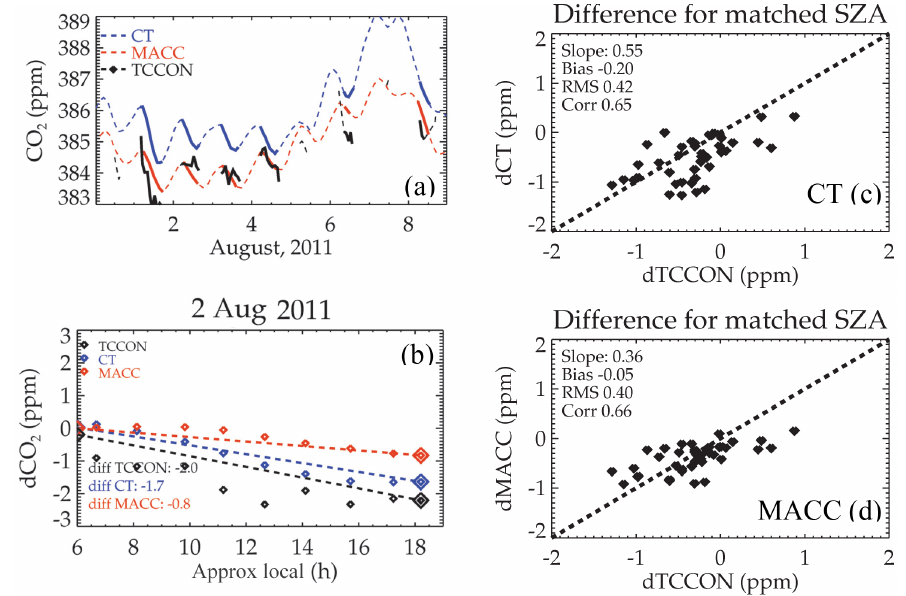
Figure 12. (a) Time series for models and TCCON from 1 to 8 August 2011 at Bialystok. The end points of the solid lines show the time points used for comparing daily variability; both diurnal and synoptic variations are seen. (b) Change throughout the day at Bialystok for 2 August 2011. The large diamonds at 06:00 and 18:00 show the two times with largest difference that have the same solar zenith angle that are used in the analysis. The difference between these times are − 2, − 1.7, and − 0.7ppm for TCCON, CT2013, and MACC, respectively. Right: CarbonTracker (c) and MACC (d) daily trends vs. TCCON daily trends for BIALYSTOK in JJA, from compiling differences as shown in (b) . Correlation is seen in the daily trends as compared to TCCON with the daily amplitude for the models smaller than